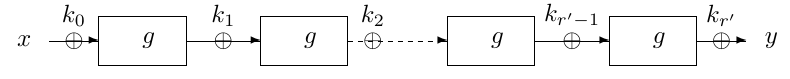
Figure 1: Key-alternating block cipher of r 0 rounds with round function g and expanded encryption key ( k 0 , k 1 , . . . , k r 0